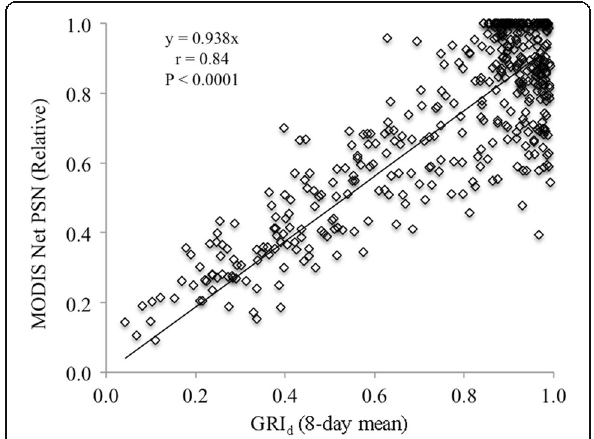
Fig. 6 Relationship between FORECAST Climate and MOIDS data for model evaluation. Based on the comparison between simulated daily growth response index (GRI d ) (summarised with 8-day means) and average 8-day composite MODIS Net PSN values for the study area (converted to relative values using annual maxima) for the period from 2000 through 2010. The regression line was forced through the origin